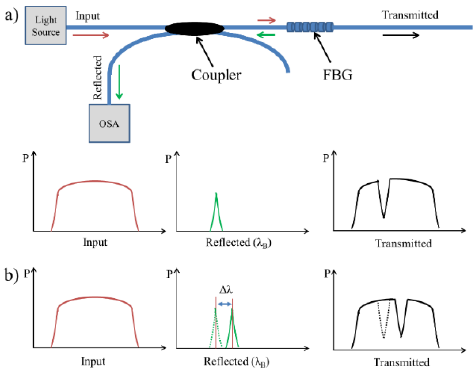
Figure 3: Principle of FBG performance.